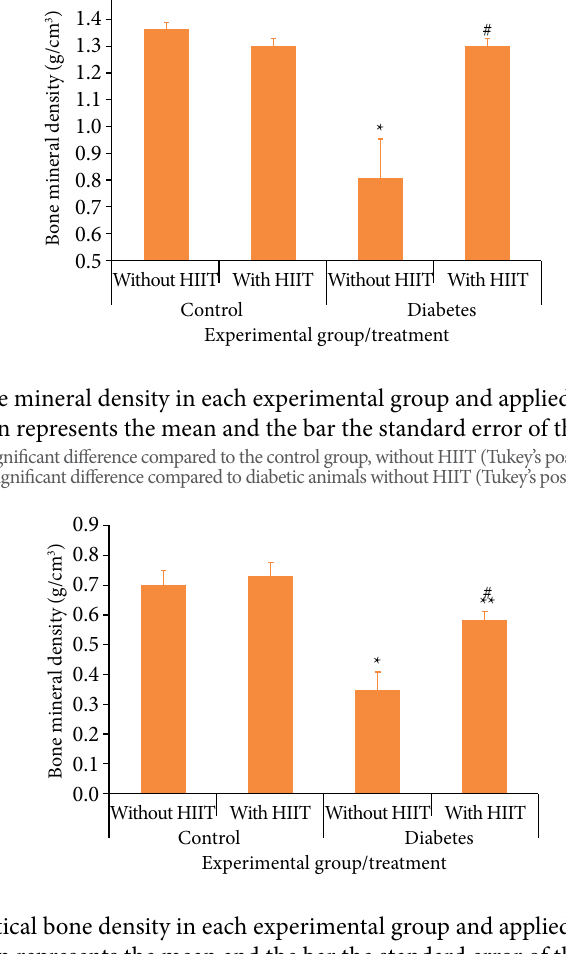
Figure 3 - Cortical bone density in each experimental group and applied treatment. Each column represents the mean and the bar the standard error of the mean.